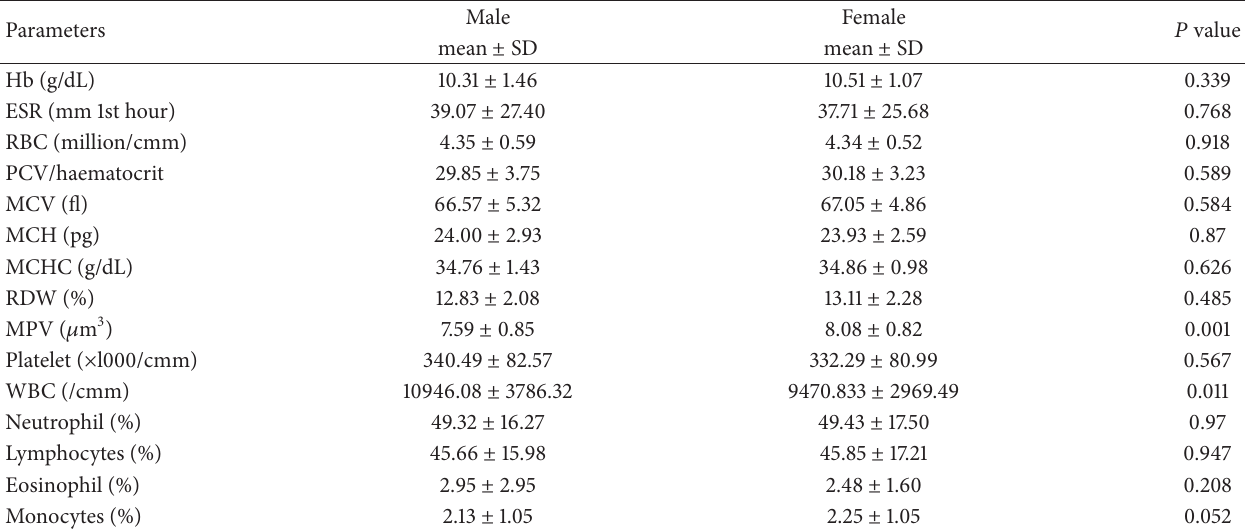
Table 2: Showing comparative hematological values for iron deficiency anemic males and females.